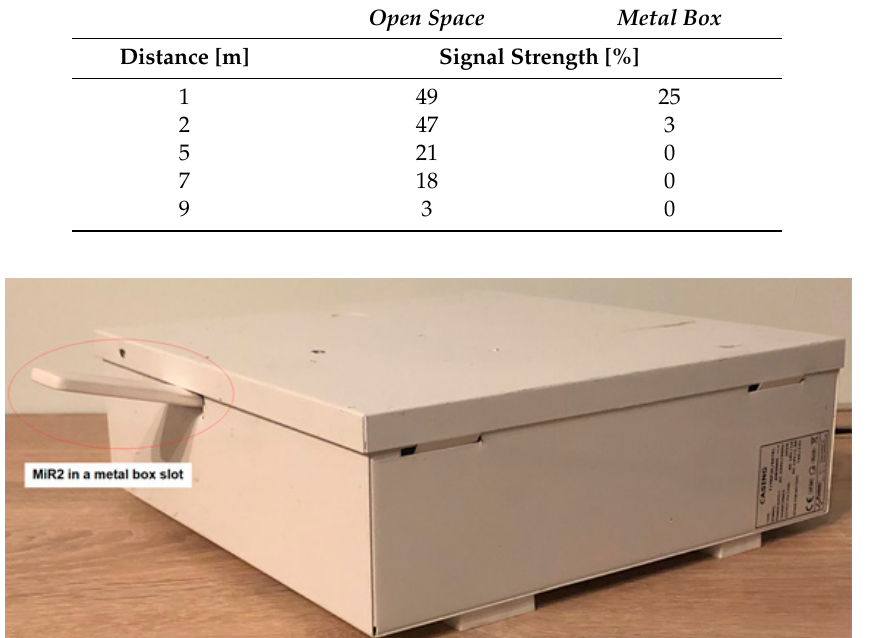
Figure 12. View of the metal box used in tests. The WiFi repeater is also visible in the gap made in the box. Table 3. The results of the AP and MiR2 strength signals during the tests 3-5.